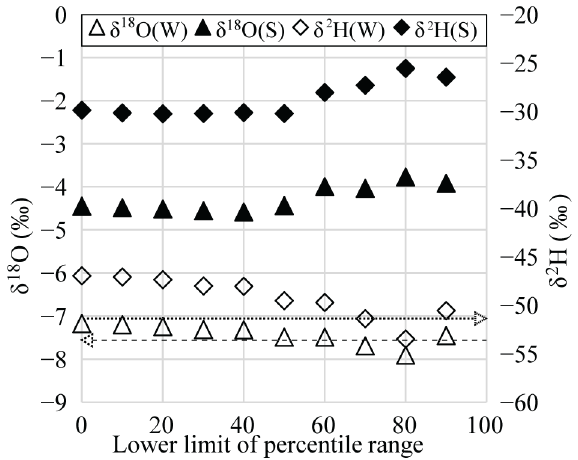
Figure 9. Amount-weighted average δ 18 O and δ 2 H values as a function of the size of rain events. As an example, the points for 80% correspond to an amount-weighted average of the largest 20% of rain events. Dashed (dotted) line points to δ 18 O (δ 2 H) value of local recharge in the region (site 14). Plot based on Table S2 for precipitation at OPCNM. S = summer, W = winter.